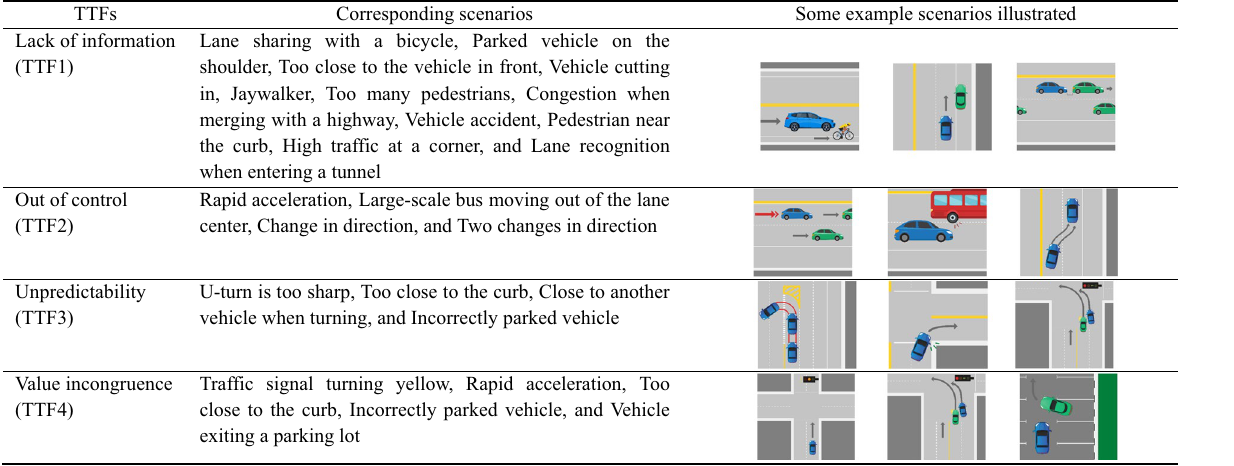
Table 3 TTF-specific scenario classification based on the experimental data TTFs Corresponding